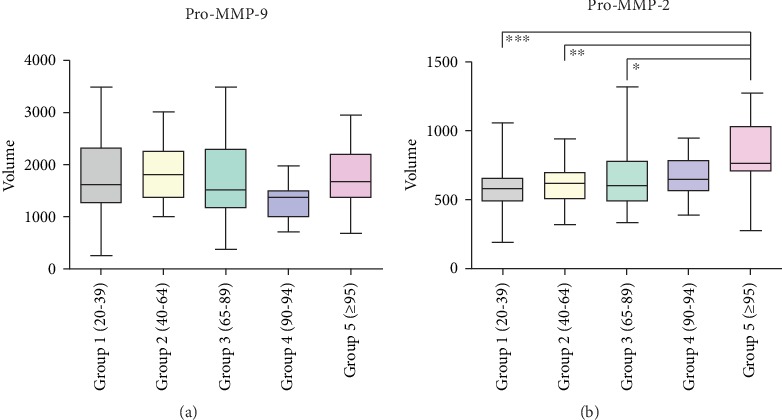
Box plot graphs of Pro-MMP-9 (a) and Pro-MMP-2 (b) activity levels evaluated by gelatin zymography grouped for age. The ends of the box are the upper and lower quartiles, the lines extending parallel from the boxes are used to indicate variability outside the upper and lower quartiles while the median is marked by a vertical line inside the box. The densitometric analysis, performed by measuring the intensity levels of each band and the corresponding area, is referred as volume. Statistical analysis was performed applying the Kruskal–Wallis nonparametric test. ∗p < 0.05, ∗∗p < 0.01, and ∗∗∗p < 0.001.